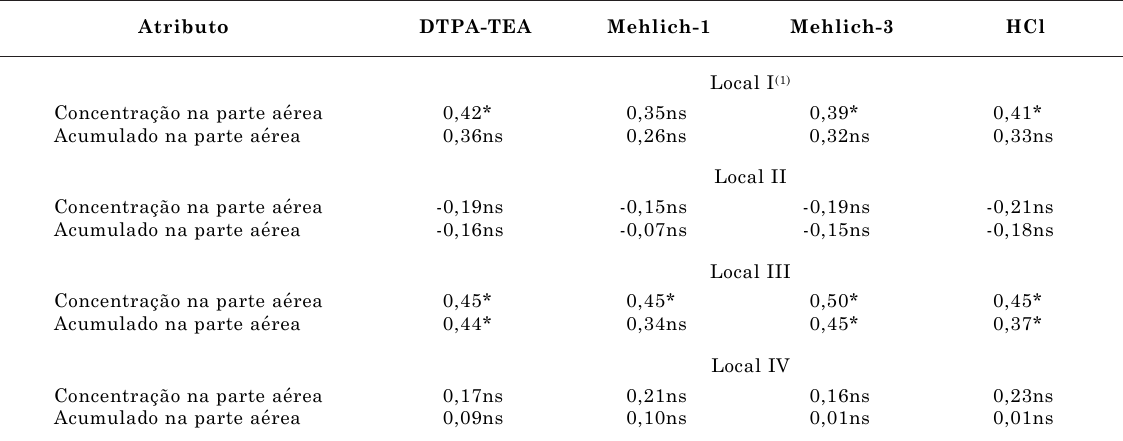
(Figura 1) podem explicar a ausência de resposta na produtividade de soja observada neste trabalho e por outros autores (Pauletti, 1998; Silva, 2000) em solos sob SSD, deficientes do nutriente.